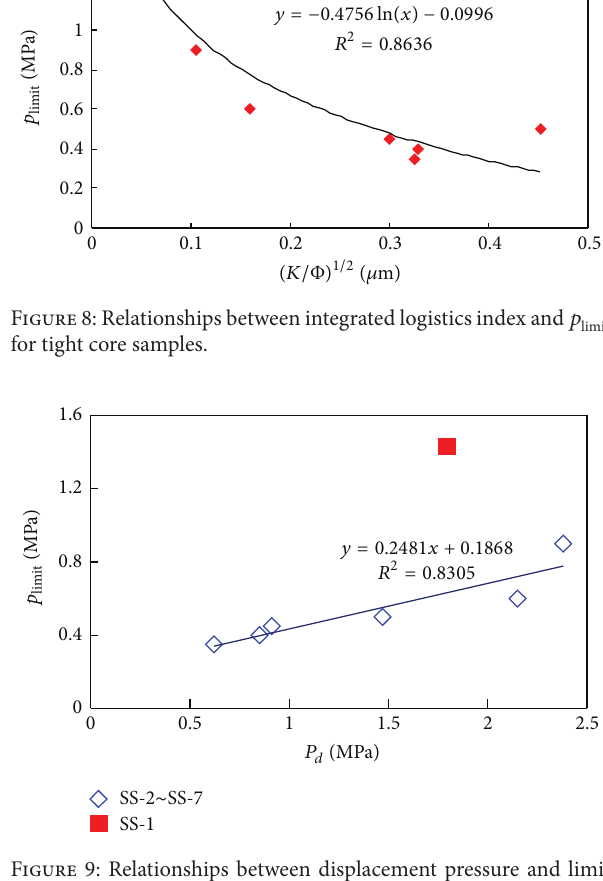
Figure 9: Relationships between displacement pressure and limit pressure for core